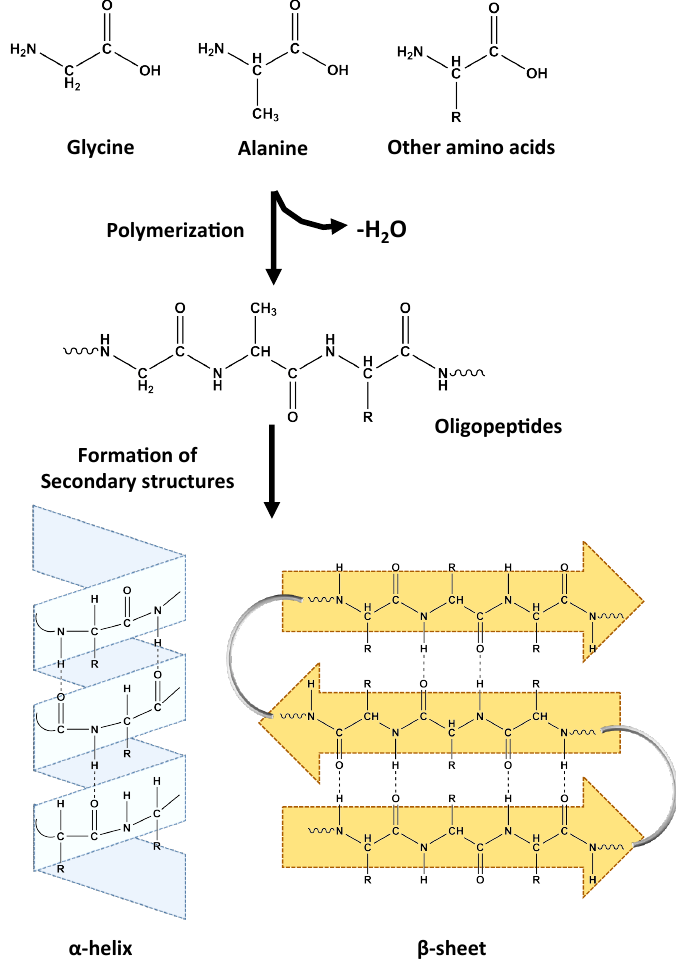
Figure 1. The components of proteins—amino acid monomers polymerize and then assemble. The assembled structures enable catalytic